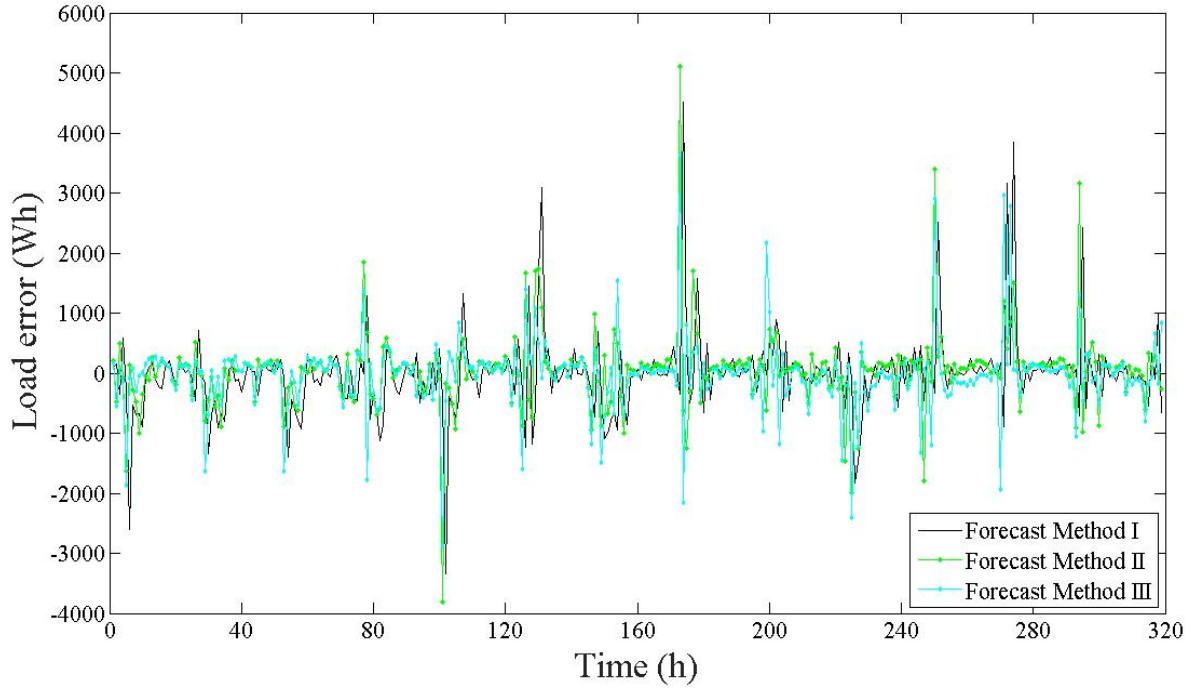
Figure 9. Training error for forecast hourly load of working days of household No 73.